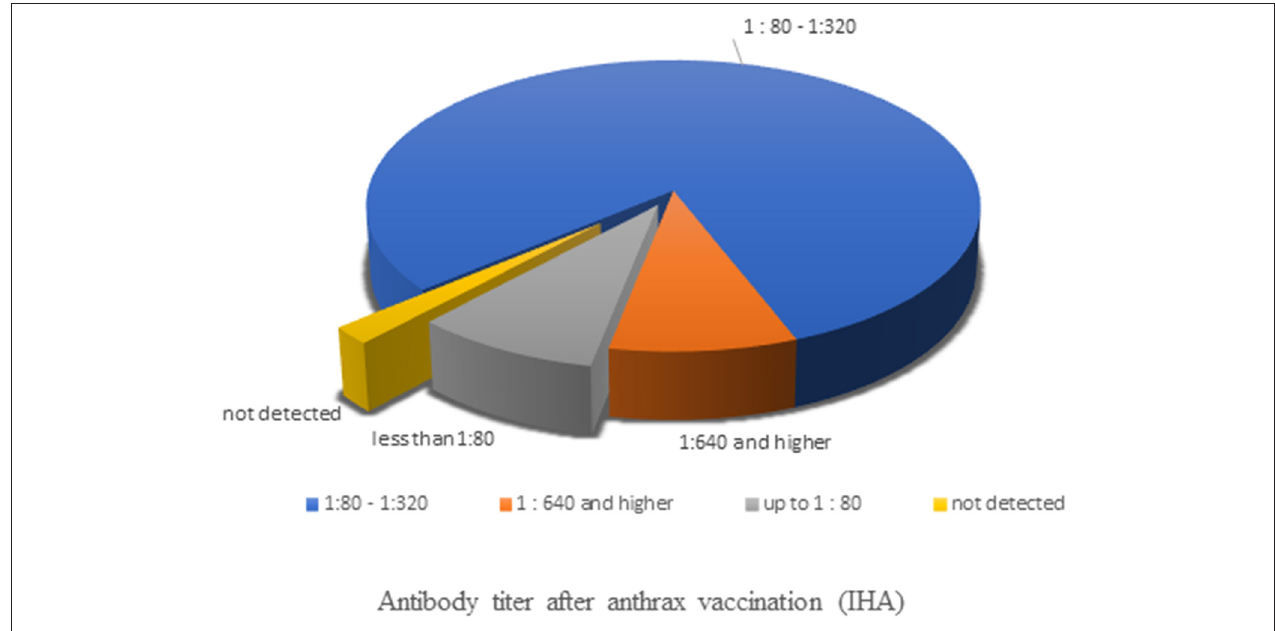
FIGURE 3 | The results of blood serum sample analysis in the indirect hemagglutination